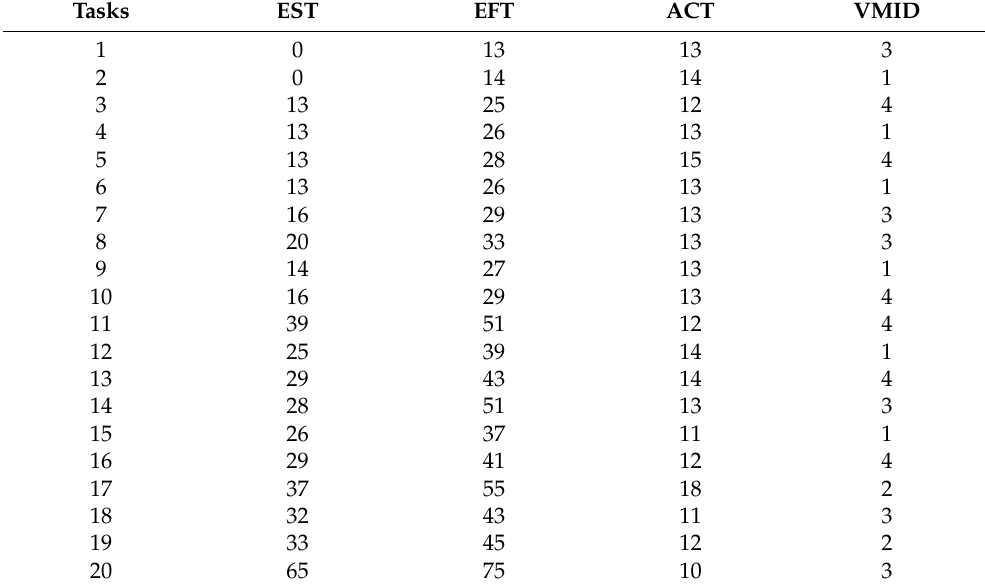
Table 5. Tasks allocation and execution